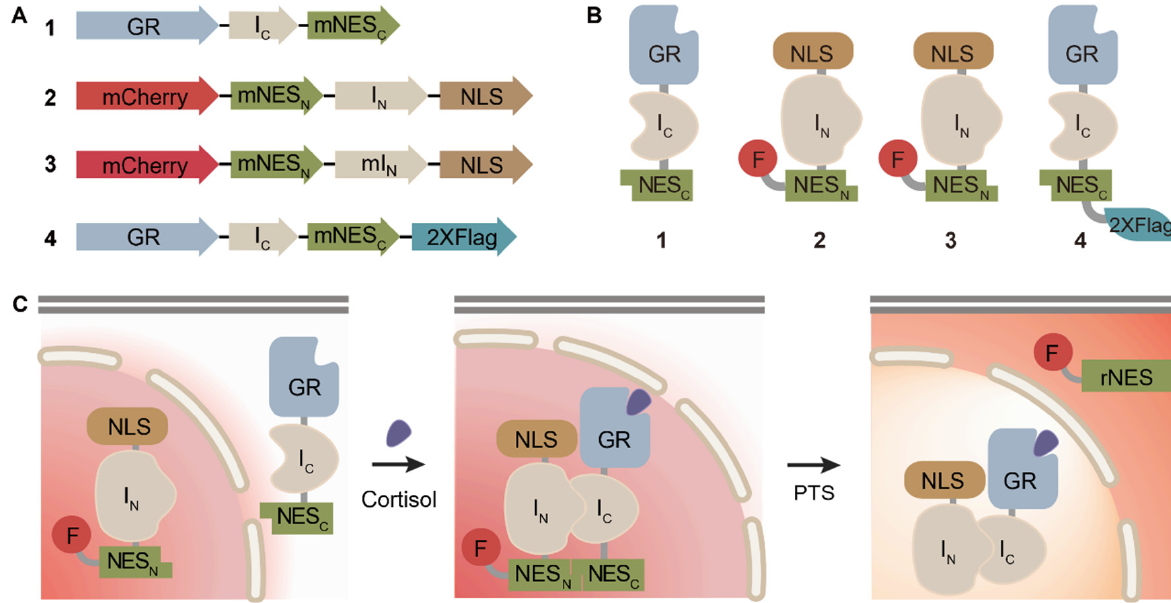
Figure 1. Design and working mechanisms of the cortisol-detecting sensor cells. The domain architecture ( A ) and schematic illustration ( B ) of fusion proteins used in this study; GR, glucocorticoid receptor; I N , N-intein; I C , C-intein; NLS, nuclear localization signal; NES, nuclear export signal. ( C ) Two fusion proteins containing each split-intein are located in two different cellular compartments. The target, cortisol, stimulates the nuclear translocation of GR to trigger conditional protein splicing (CPS), which results in reconstitution of the NES peptide. The reconstituted signal peptide delivers the fluorescent protein to the cytosol, thereby reporting the existence of the target molecule.